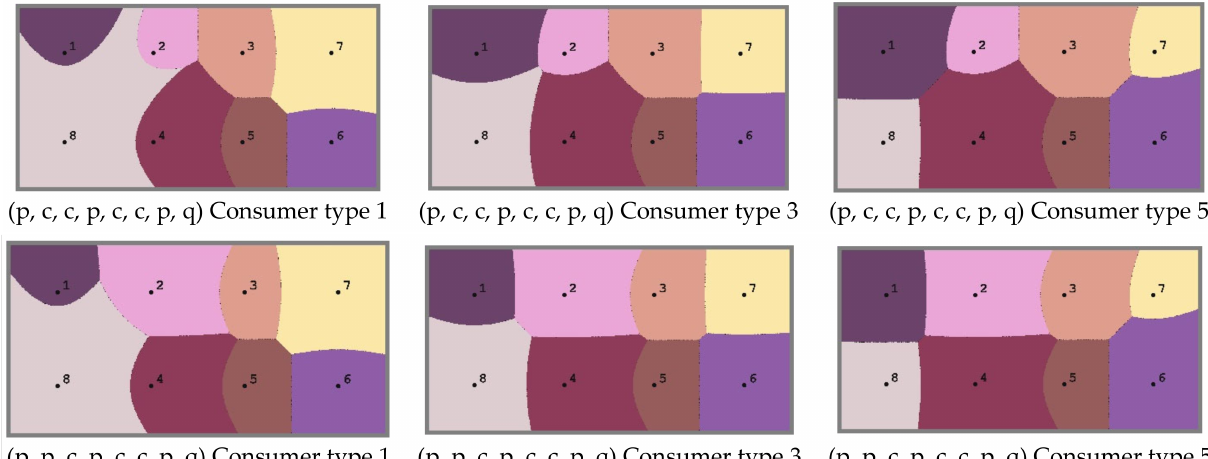
Figure 11. Comparison of consumer areas of Scenario 4 with different cartel